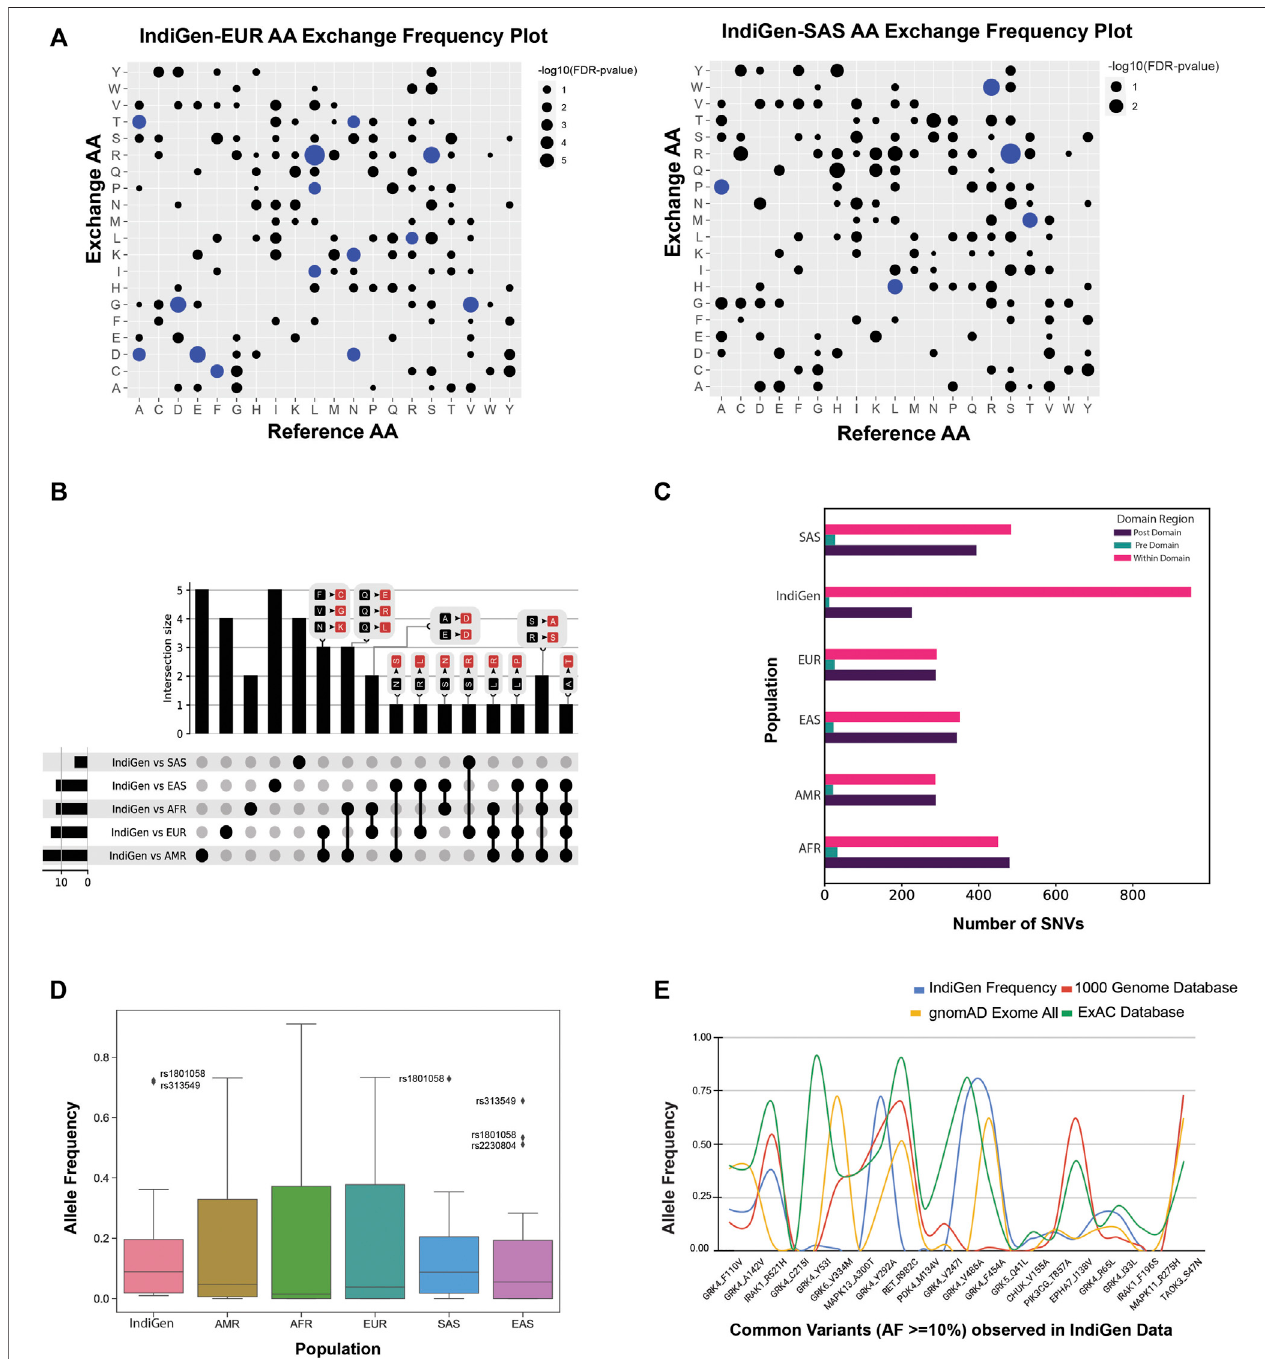
FIGURE 3 | (A) Comparing the trend of amino acid exchange among different populations from 1000 genome data with the Indian population. Bubble-plot was generated on the basisof the FDR corrected p -value associated with AA-exchangefrequency for aparticular Reference and Alternate AAobserved in IndiGen data with EUR and SAS populations of 1000 genome data. The size of the bubble is proportional to the − log10 ( p -value) linked with the amino acid exchange. AA exchanges with p -value < 0.05arehighlightedinbluecolor. (B) AnUpSetPlotofstatisticallysigni fi cantAAexchangesobservedinIndiGenw.r.ttootherpopulationsin1000Gdata. (C) A grouped bar plot showing the count of variations lying before (green), within (pink), and after the domain (violet) for variants in IndiGen and populations in 1000G data. (D) A Box-plot for comparing allele-frequency distribution of common IndiGen variants (AF ≥ 10%) qualifying the fi lters used for structure data (22 variants) with different populations in 1000 genome data. (E) IndiGen speci fi c SNVs (22 variants in structure data) with AF ≥ 10% observed in different databases like 1000 genome project, gnomAD exome data, and ExAC database; with IndiGen variations on X-axis and their allele frequencies in different databases on Y-axis.